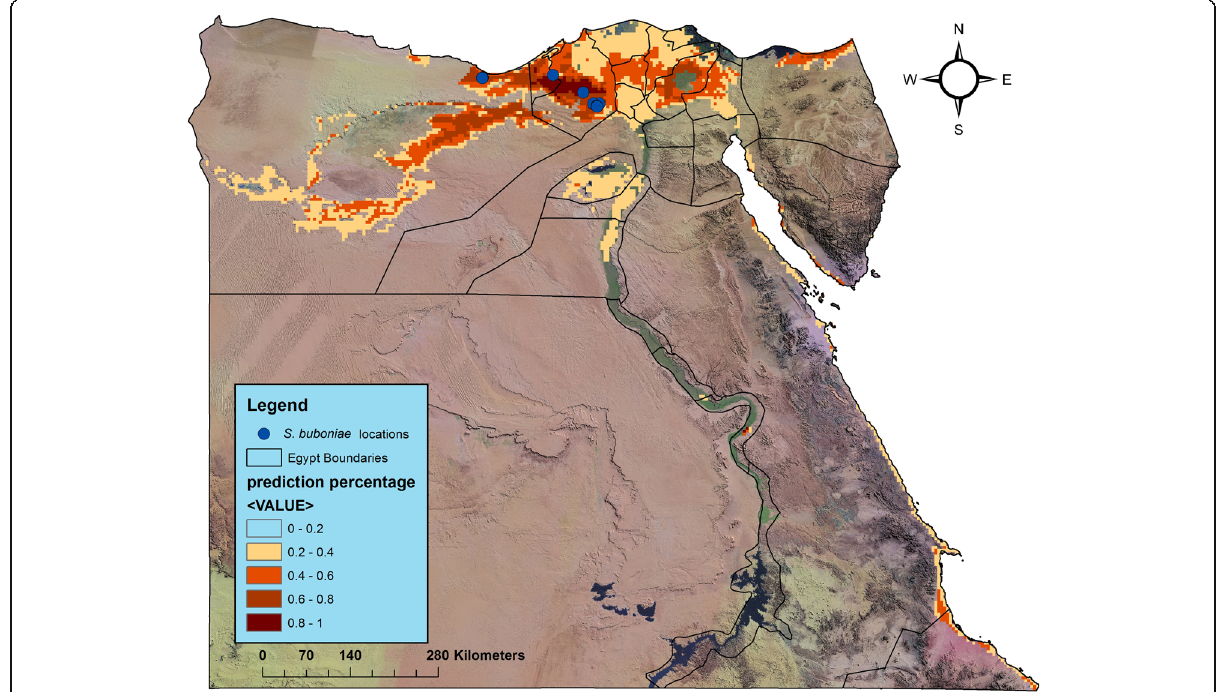
Fig. 6 The predicted distribution range of the S. buboniae according to the MaxEnt model (map source: IESR, GIS unit, and Google Maps https://www.google.com.eg/maps/@27.4846067,31.3939551,6z)